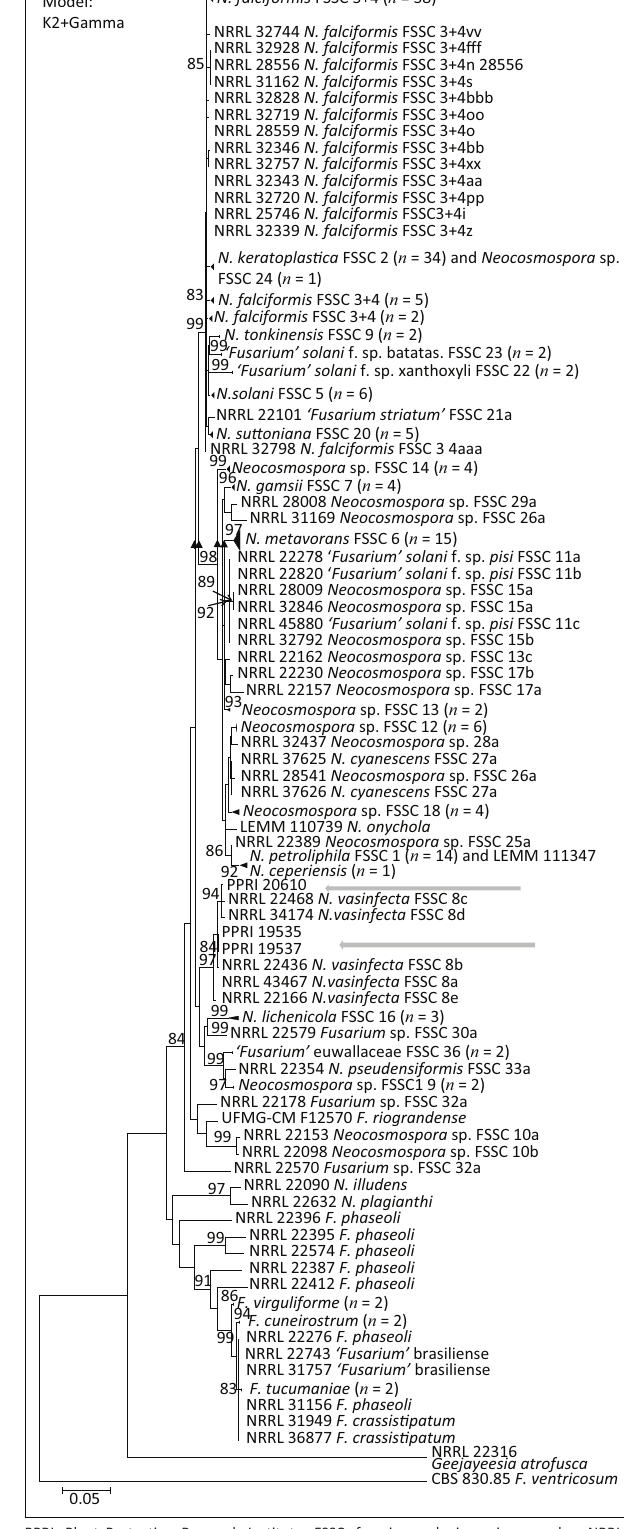
FIGURE 2: Unrooted maximum likelihood phylogram of all currently sequenced Fusarium species in the Fusarium solani species complex (also referred to as Neocosmospora with some species named as Neocosmospora ) based on translation elongation factor 1-a gene sequences. Bootstrap support values higher than 80 % are shown on the branches. The evolutionary model applied to the analysis is indicated on the figure. Isolates from this study are indicated with PPRI numbers.